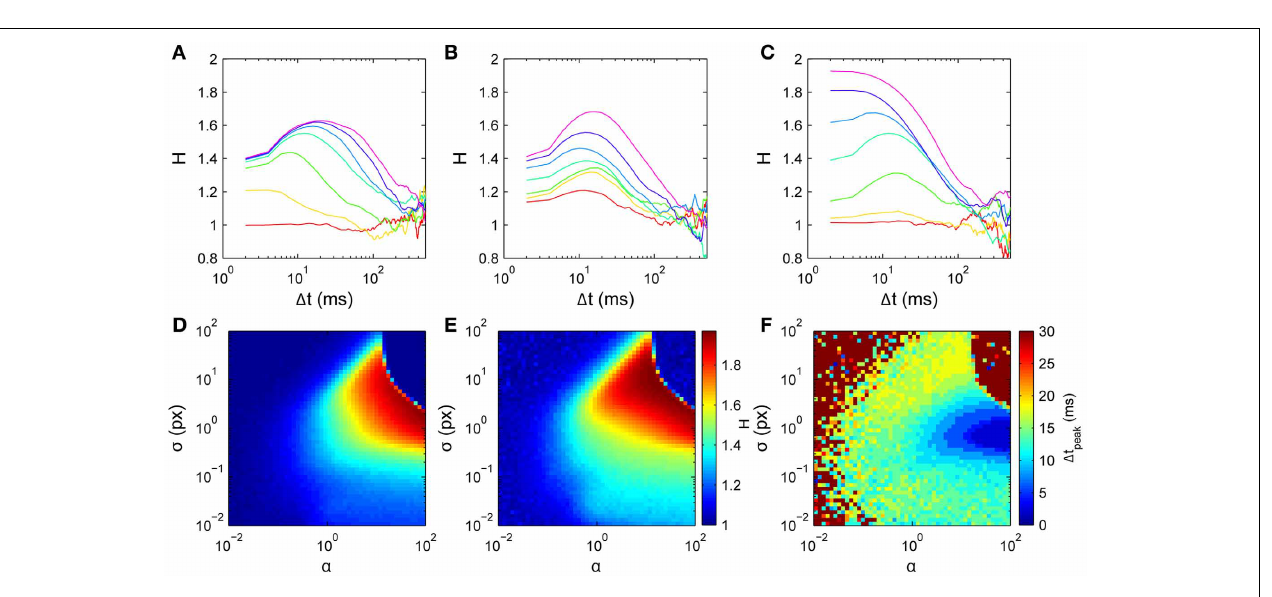
FIGURE 8 | Model scaling exponent parameter dependences. Simulations used D 2 curves averaged over 100 walks of 500 steps, around the nominal parameter set τ = 10 time points (20ms), α = 1, and σ = 1px. (A) Varying memory length τ ; curves from bottom to top are for τ = 0 , 2 , 5 , 10 , 15 , 20 , 25 time points, respectively. (B) Varying